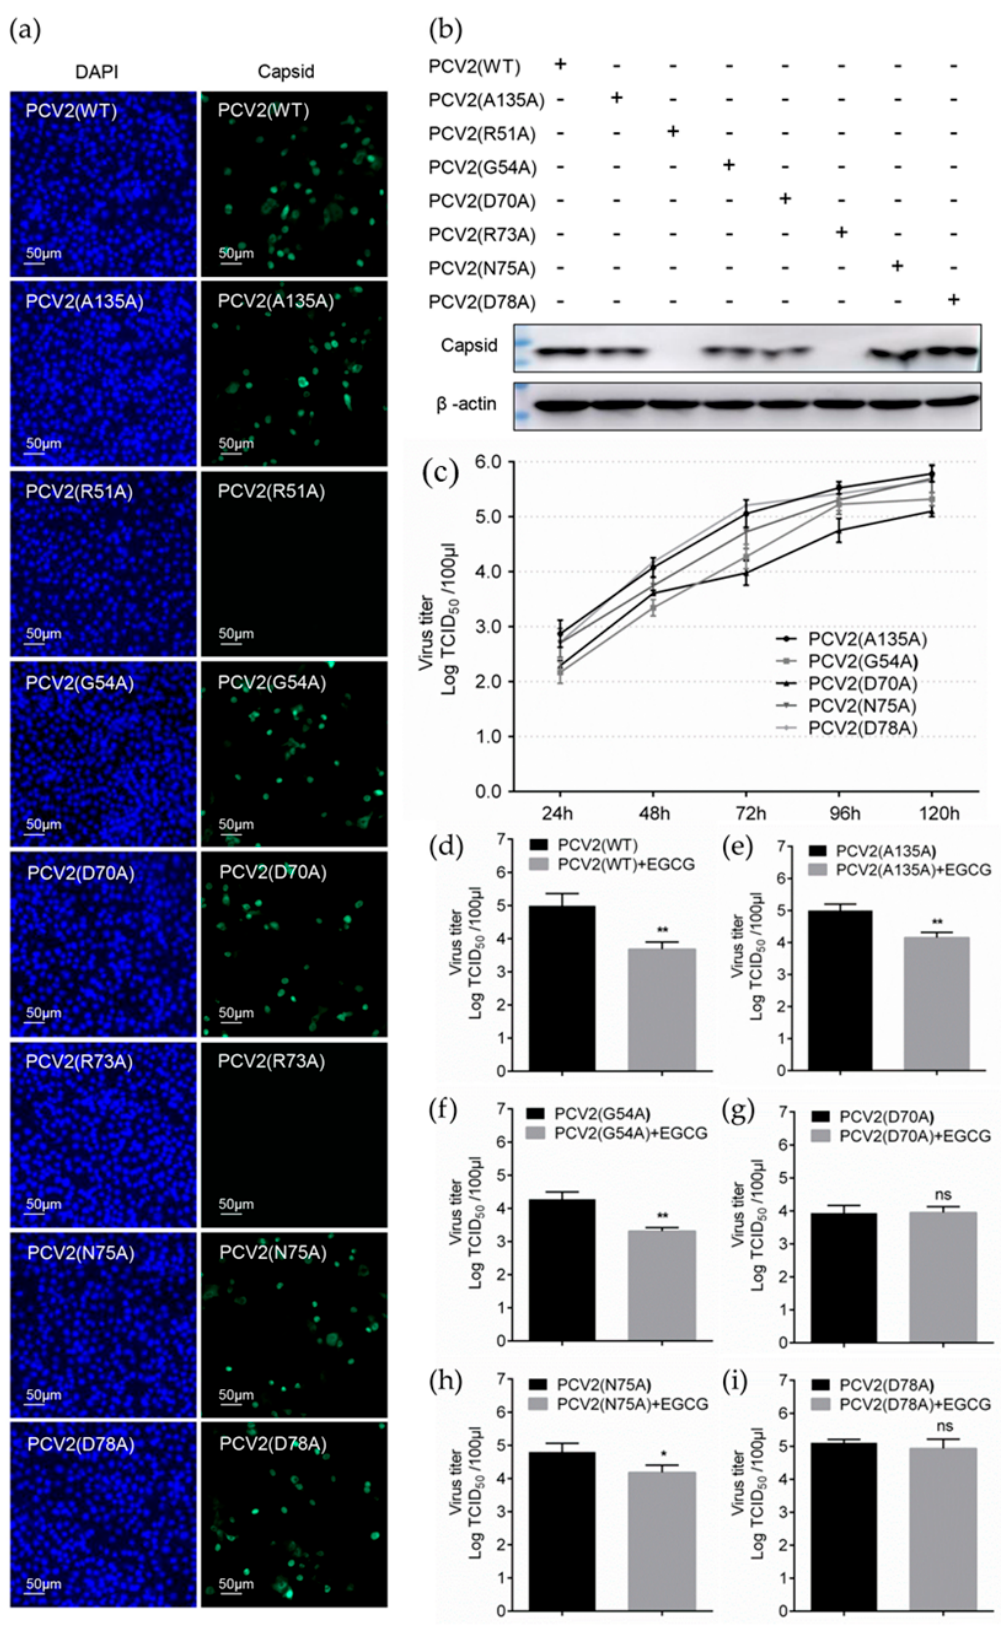
Figure 7. Regulation of EGCG antiviral activity by replacement of key amino acids in capsid. ( a , b ) The infectivity of rescued PCV2 mutants. The rescued PCV2 mutant virus was inoculated into PK-15 cells